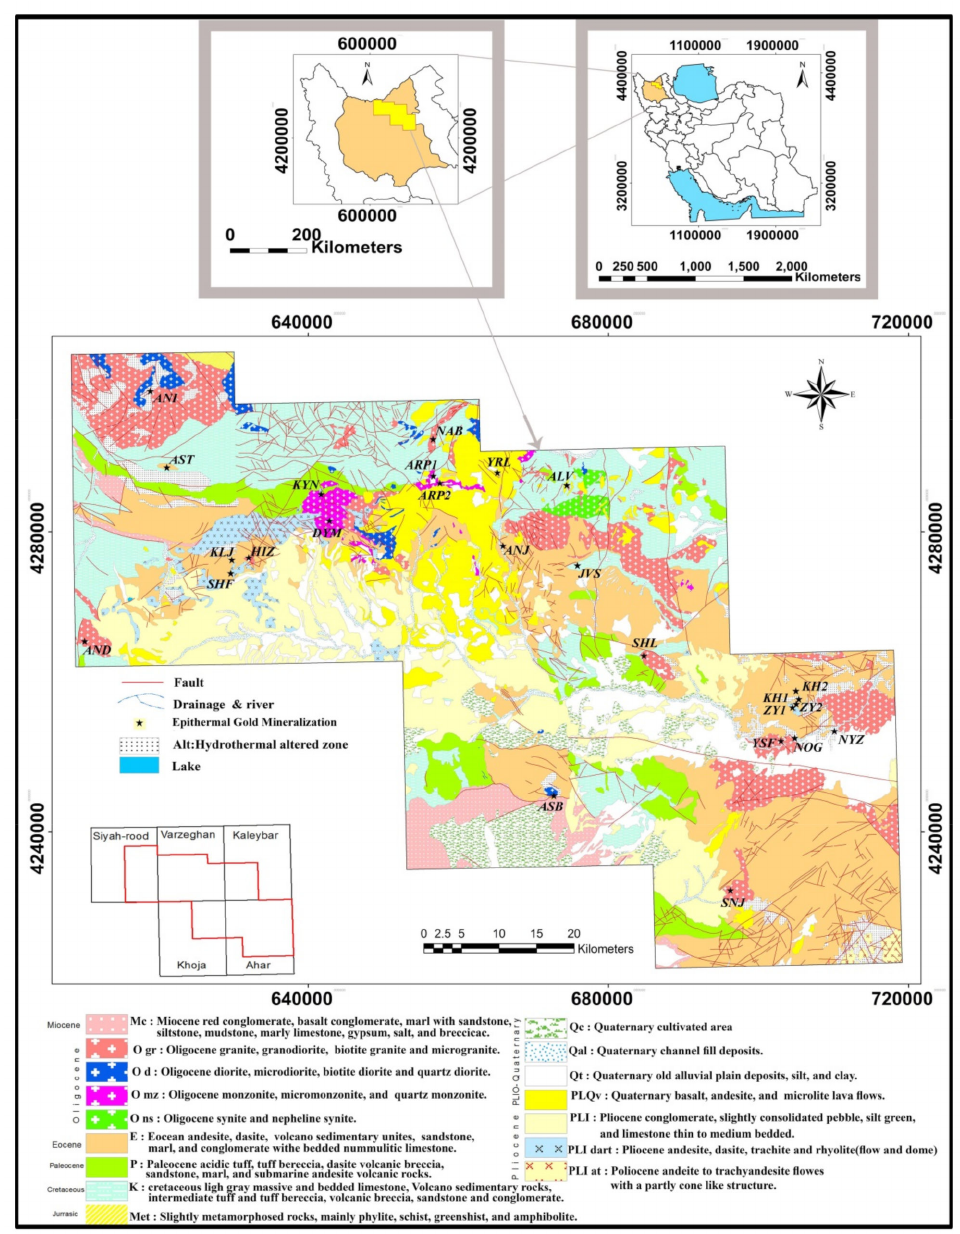
Figure 1. Geological map of the Ahar-Arasbaran region. Modified from five 1:100,000 geological map sheet provided by the Geological Survey of Iran [56]. Abbreviation to epithermal gold mineralization: ANI = Annigh; AST = Astamal; AND = Andiryan; KLJ = Kalijan; SHF = Sharaf-abad; HIZ = Hize-jan; KYN = Khoyneh-roud; DYM = Day-mamagh; NAB = Nabi-jan; ARP1 = Arpaligh1; ARP2 = Arpaligh2; YRL = Yaralojeh; ANJ = Anjerd; ALV = Alavigh; JVS = Javan-sheykh; SHL = Shaleh-boran; ASB = Asb-abad; SNJ = Sonajil; YSF = Yosoufloo; NOG = Noghdouz; NYZ = Niyaz; ZY1 = Zailigh1; ZY2 = Zailigh2; KH1 = Khiarloo1; KH2 =